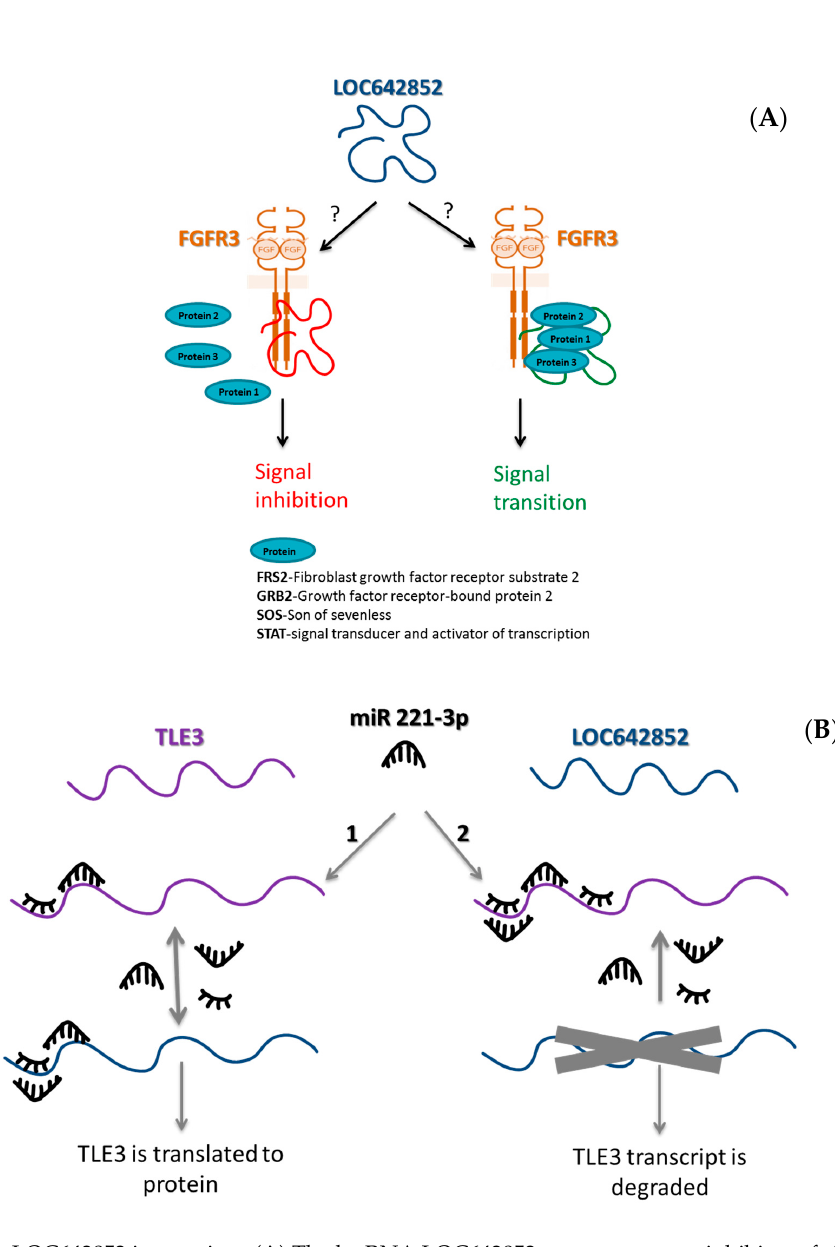
Figure 6. LOC642852 interactions ( A ) The lncRNA LOC642852 may serve as an inhibitor of signaling for FGFR3 by preventing crucial proteins, such as signal transducer and activator of transcription (STAT) and Fibroblast Growth Factor Receptor Substrate 2 (FRS2) to access the receptor, or alternatively, as a scaffold for the assembly of different proteins such as FRS2, Growth Factor Receptor Bound Protein 2 (GRB2), Son of Sevenless (SOS), and STAT. ( B ) LOC642852, TLE3, and miR-221-3p ceRNA network. At option (1), both transcripts are expressed, miR-221-3p is divided between them, and TLE3 is translated to a protein. At option (2), when LOC642852 is not expressed, all miRs are attached to TLE3, causing its degradation.